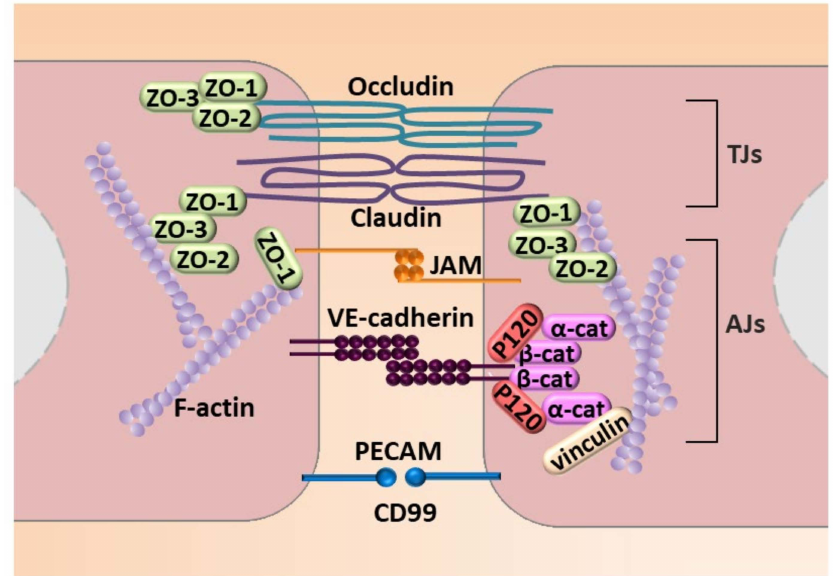
Figure 4. Molecular mechanisms engaged in endothelial cell–cell junction. The figure illustrates adhesion molecules that regulate AJs that consist of VE-cadherin with zonula occludes-1, -2, and -3 (ZO-1, ZO-2, and ZO-3) that interact with a complex of P-120, and a α -cathenin and β -cathenin ( α -cat and β -cat, respectively) complex that connects VE-cadherin to stress fibers created by fibrillar actin (F-actin). TJs are created by occludin and claudin and JAM that interacts with ZO-1, ZO-2, and ZO-3. An additional element of cell–cell contact is the